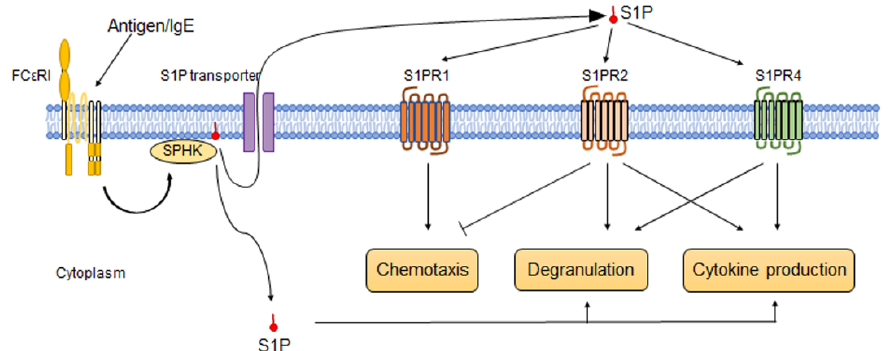
Figure 4. S1P and S1P-S1PR pathways of mast cells. Recognition of antigens via IgE-Fc ε RI, the plasma membrane of mast cells, activates SPHK, thereby promoting the generation of S1P. The generated S1P stimulates degranulation and cytokine production intracellularly. On the other hand, S1P released into the extracellular space also acts in an autocrine manner via S1P receptors expressed on mast cells. Mast cells express three S1P receptors, S1PR1, S1PR2, and S1PR4, but not S1PR3 and S1PR5. S1PR1 activates mast cell chemotaxis; meanwhile, S1PR2 suppresses it. S1PR2 and S1PR3 promote mast cell degranulation and cytokine production.